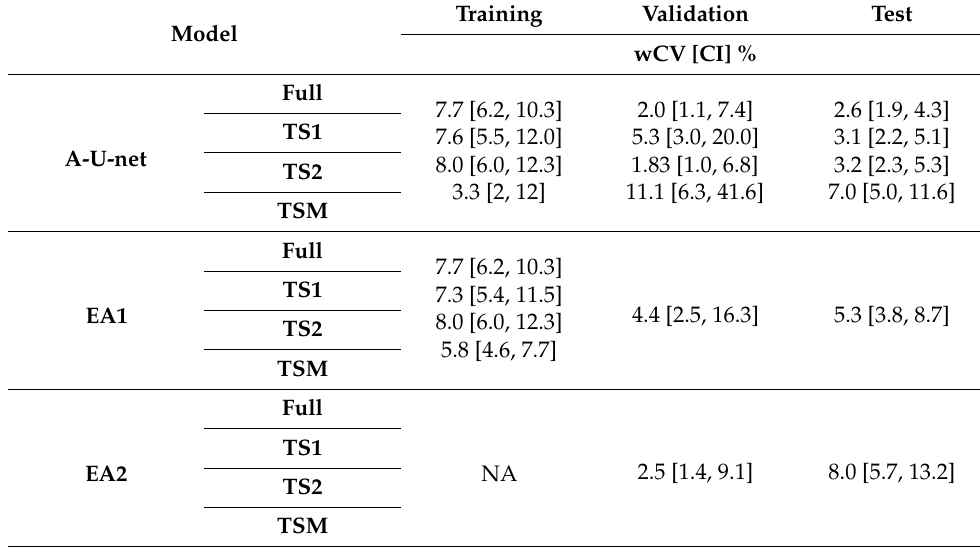
Table 2. The repeatability of volume estimations in terms of %wCV and confidence intervals [CIs] in all data subsets for A-U-net model and EA1, EA2 expert annotations and different DL model training scenarios (Figure 1: full, TS1, TS2, TSM). Training Model